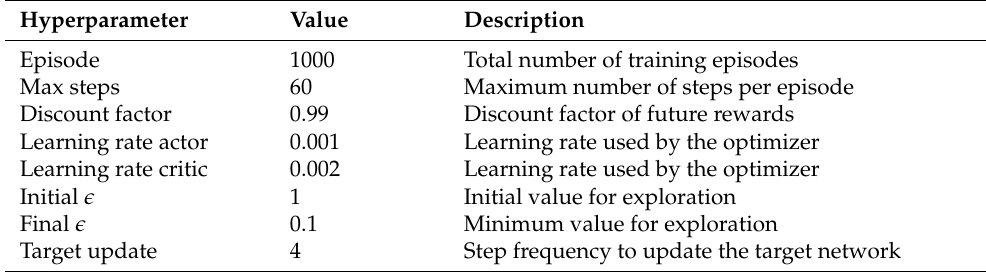
Table 2. Hyperparameters for the DDPG